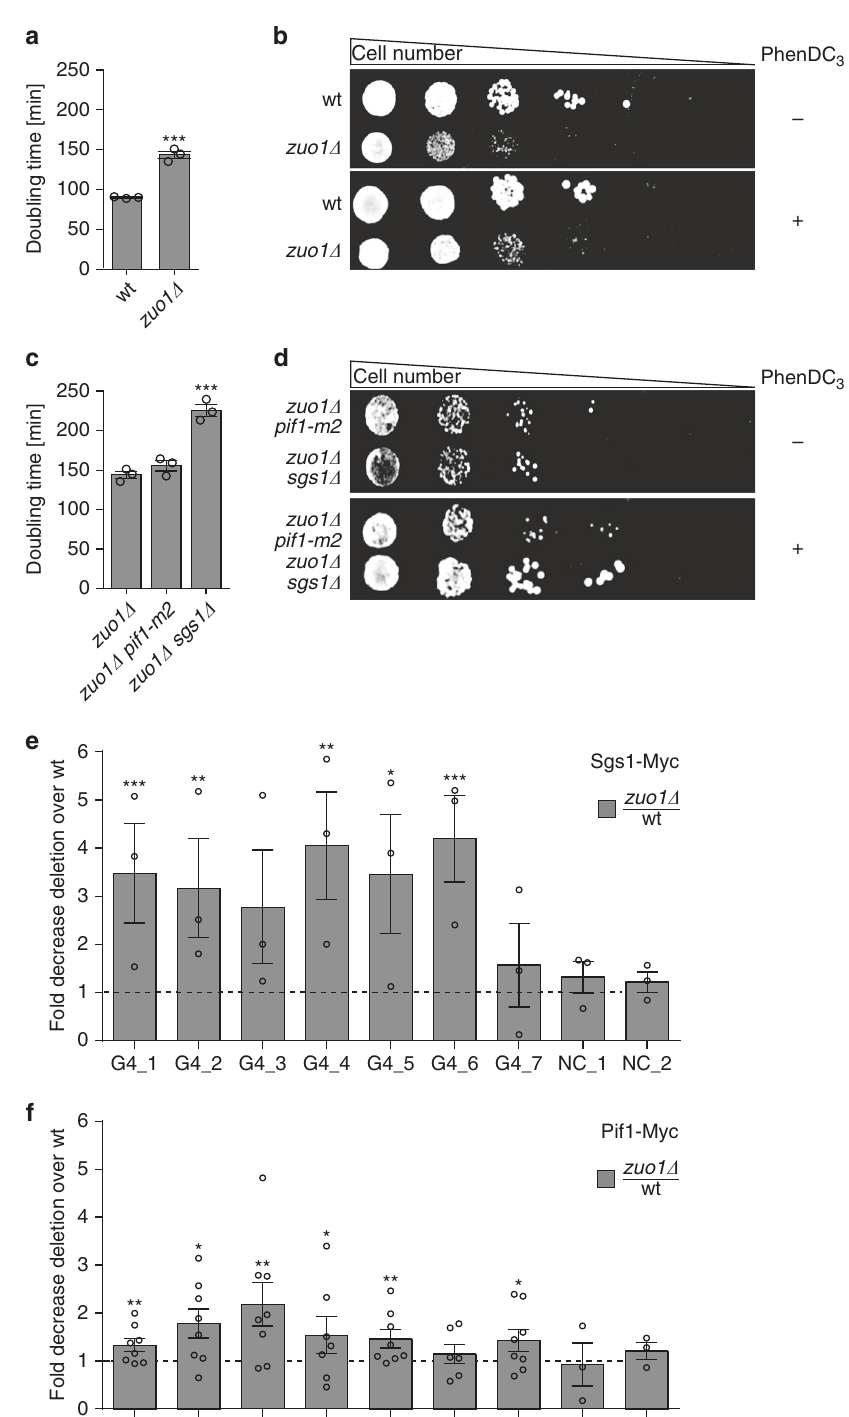
Fig. 3 Zuo1 function at G4 has a positive effect on cellular fi tness. a – d Monitoring of growth changes in different yeast cells a , c Growth curves in liquid media were performed and doubling times (minutes) were calculated using the indicated yeast strains. Plotted are the means of n = 3 biologically independent experiments. Error bars present ±SEM. Signi fi cance was calculated based on one-sided Student ’ s t -test. Asterisks indicate statistical signi fi cance: * p < 0.05, ** p < 0.01, *** p < 0.001. b , d A serial dilution of yeast cells was spotted on rich media with and without 10 µ M PhenDC 3 . Growth changes and sensitivity of n = 3 biologically independent experiments were monitored by colonies formation. e , f ChIP analysis followed by qPCR that monitored the binding of either Sgs1 ( e ) or Pif1 ( f ) to seven Zuo1 targets (G4_1 – 7) and two controls (NC_1,2) was monitored after ChIP and qPCR. ChIP was performed in wildtype and zuo1 Δ cells. Presented data show fold decrease zuo1 Δ /wt ± SEM. For all experiments, the means of three biological replicates were plotted. Signi fi cance was calculated based on one-sided Student ’ s t -test. Asterisks indicate statistical signi fi cance in comparison with wildtype cells. * p < 0.05, ** p < 0.01, *** p <